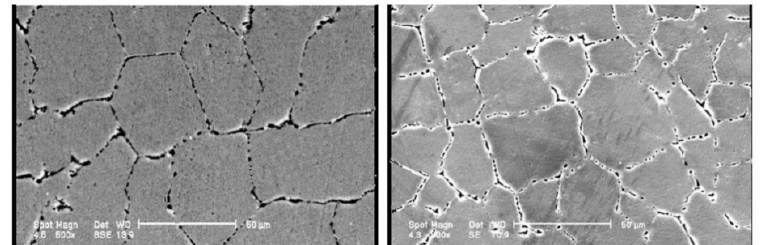
Figure 13. Microstructures of the conventional (left) and ultrasonic (right) ECAP-processed pure Al reprinted with permission from Ref. [47]. Copyright 2022, ELSEVIER.